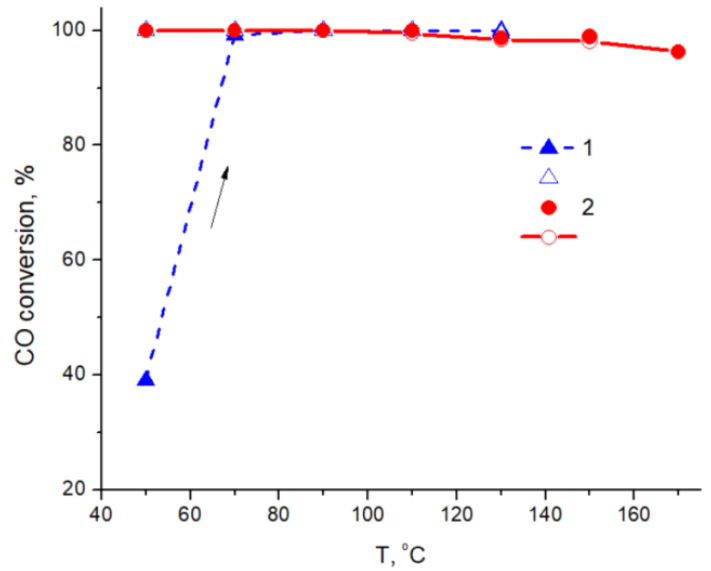
Figure 7. Temperature dependences of СО conversion on 0.05Pt/4.5Co/Z-15 in successive heating – cooling cycles (1 and 2). Shown are the data for two heating – cooling cycles: dotted line and solid symbols correspond to the heating cycle, while solid line and open symbols correspond to the cooling. The up arrow denotes heating.